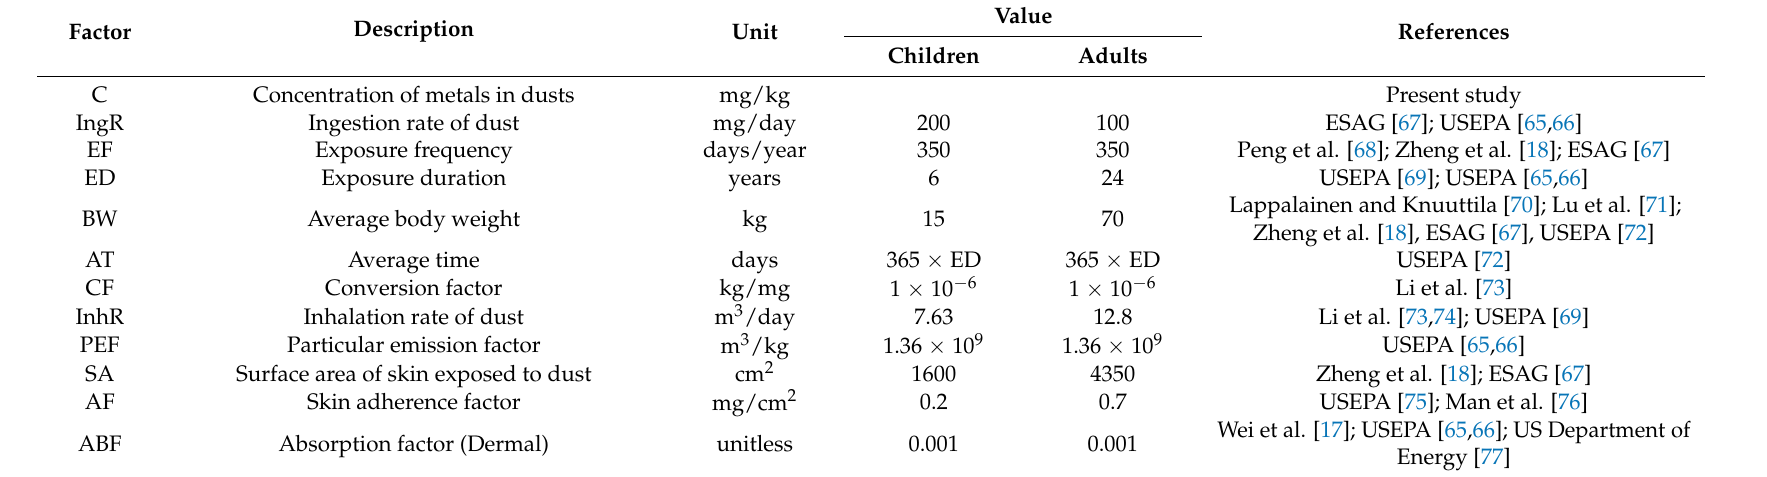
Table 2. Values of exposure factors for heavy metals doses for children and